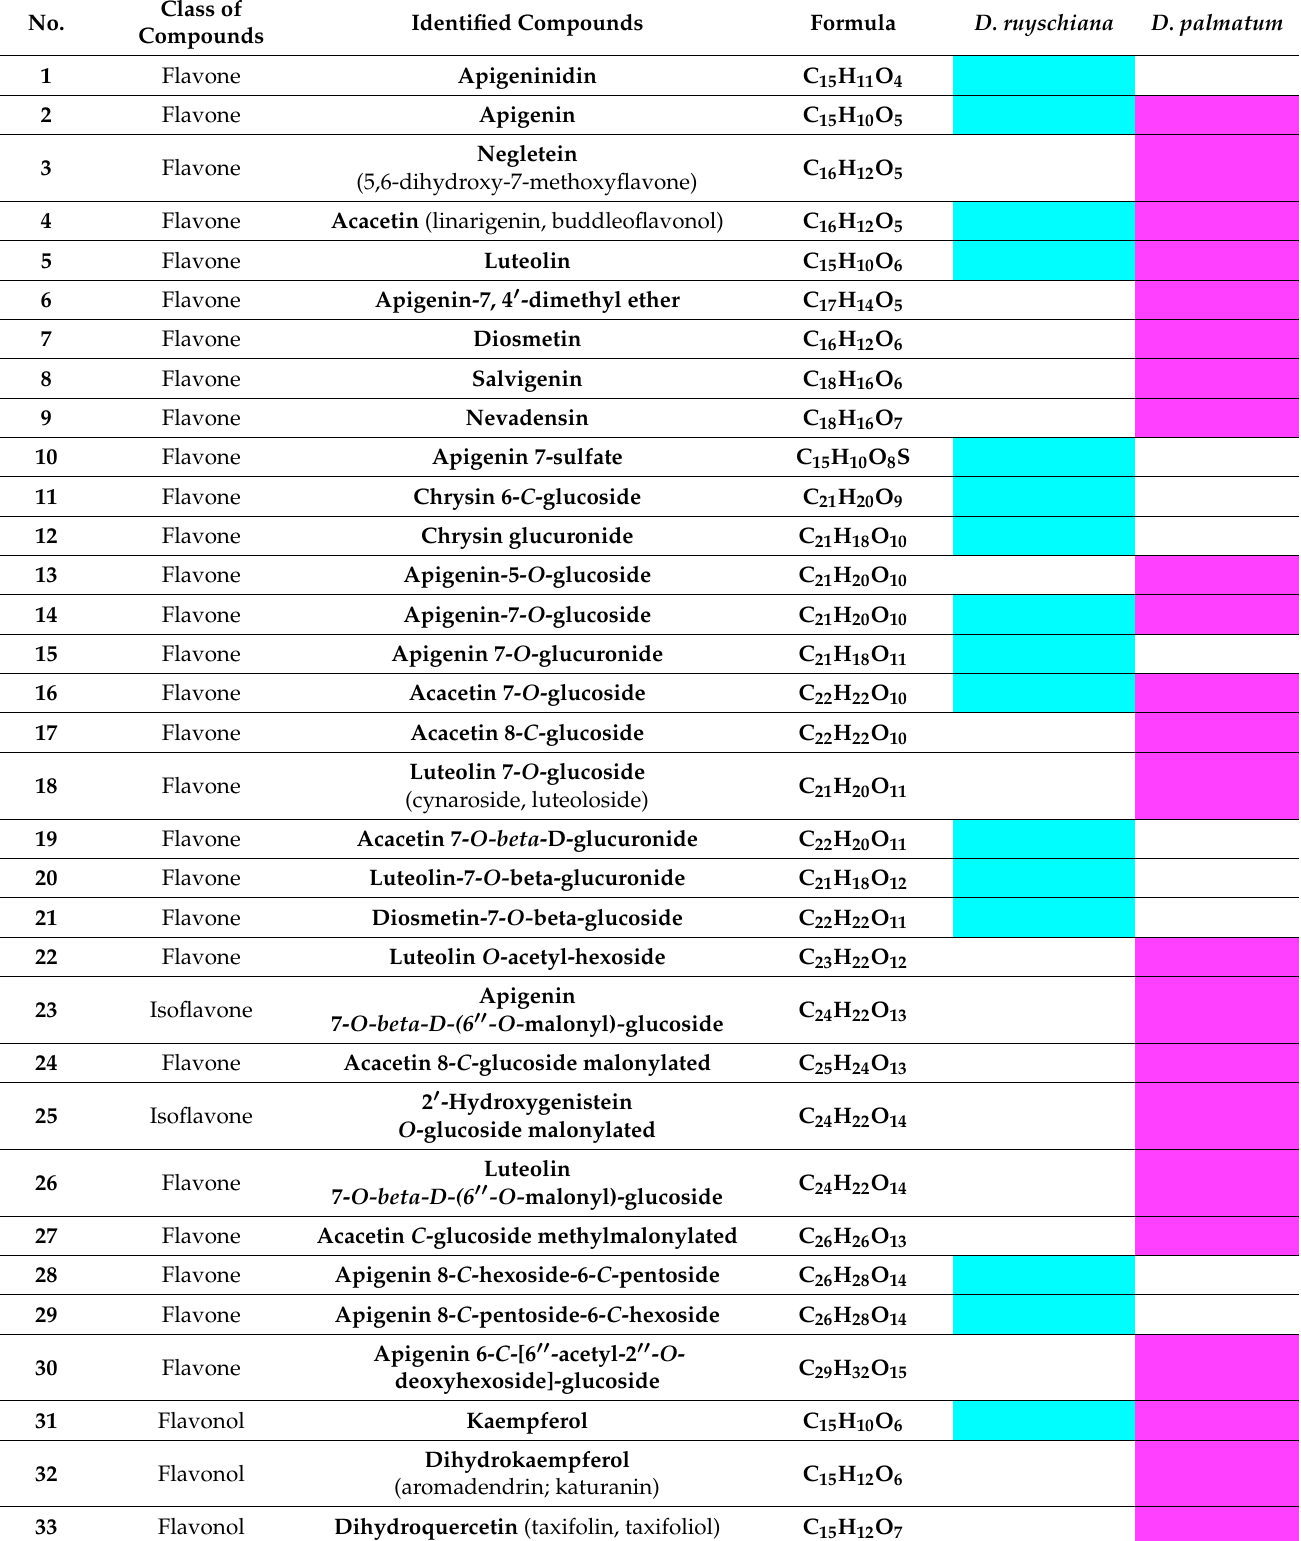
Table 1. The flavonoid composition distribution of the genus Dracocephalum L. Blue square—presence in extracts of D. ruyschiana ; magenta square—in extracts of D. palmatum